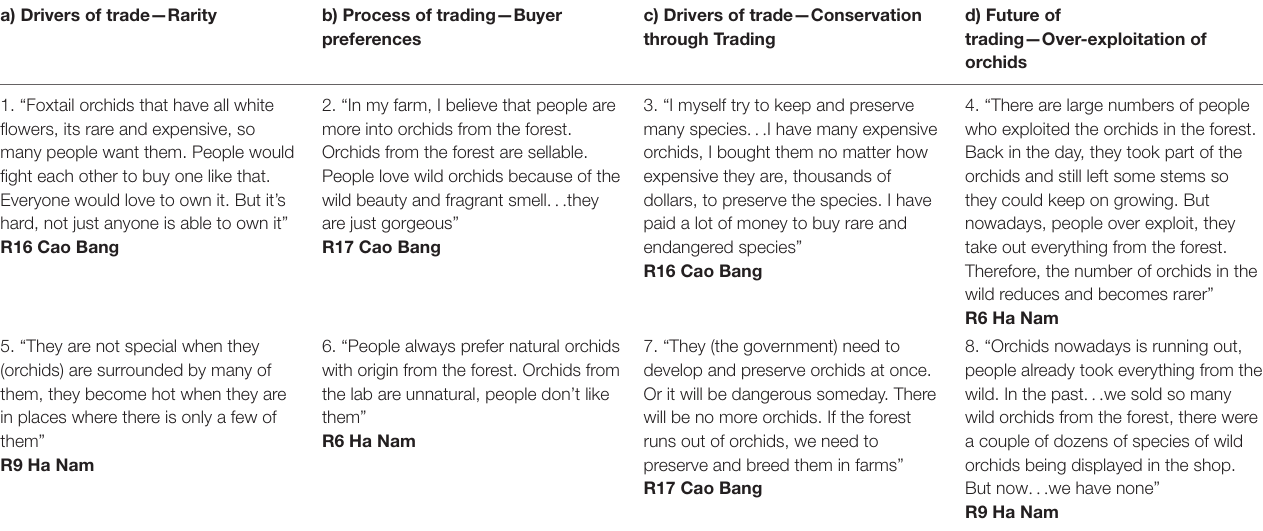
TABLE 1 | Participant quotes from interview data providing evidence for concepts identified through the thematic framework